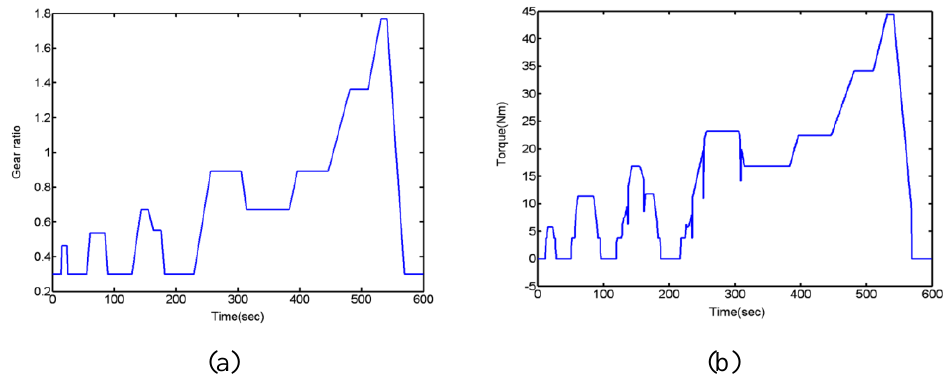
Figure 9. Output ( a ) speed reduction ratio and ( b ) torque of transmission